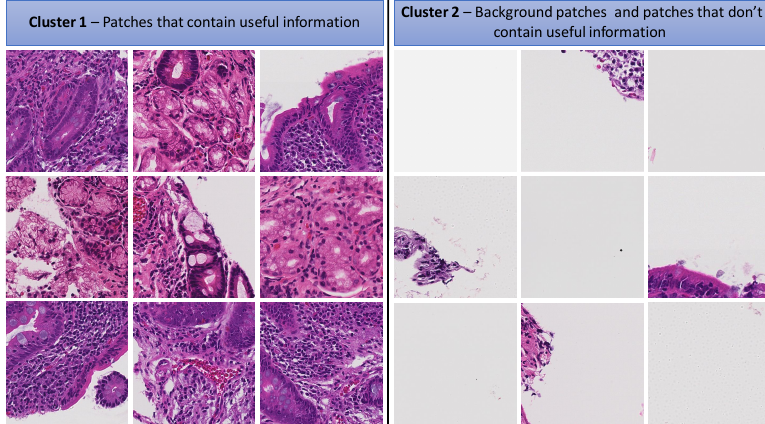
Figure 4. Some samples of clustering results—cluster 1 includes patches with useful information and cluster 2 includes patches without useful information (mostly created from background parts of